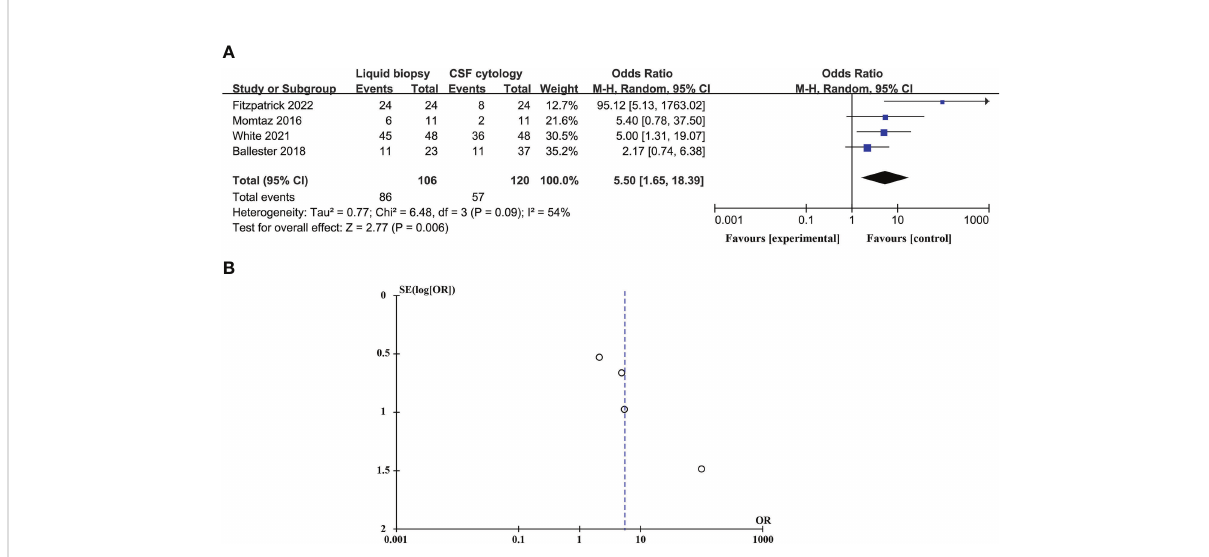
FIGURE 5 Compare the diagnostic advantages of CSF liquid biopsy techniques and CSF cytology in LM (A) . Forest plot of diagnostic advantages of CSF liquid biopsy techniques versus CSF cytology in LM. (B) . Funnel plot of diagnostic advantages of CSF liquid biopsy techniques versus CSF cytology in